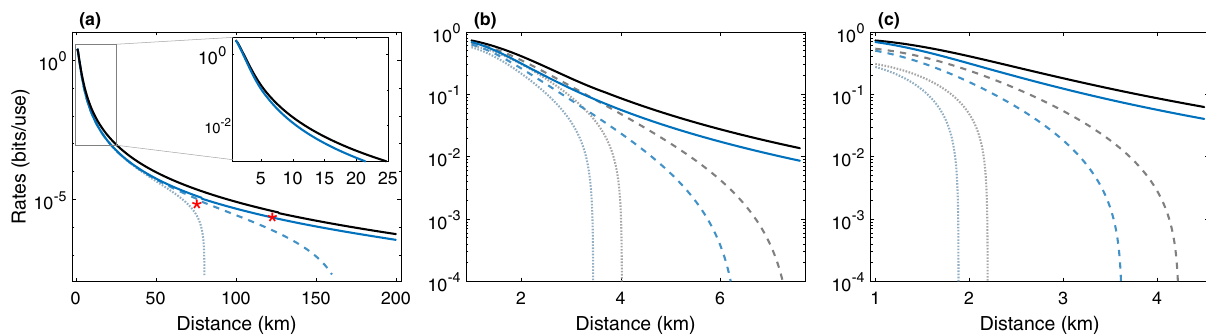
Fig. 3 Free-space optical quantum communications in a moderate-to-strong turbulent space. We indicate night- and day-time conditions by black and blue curves, respectively. In a , we plot the ultimate pure-loss bound of Eq. (20) with an ideal receiver, η eff = 1 and (cid:2) n ex ¼ 0, at night-time (solid black curves) and day-time (solid blue curve). The dashed (dotted) curves are thermal upper (achievable lower) bounds for an ideal receiver with η eff = 1 and (cid:2) n ex ¼ 0 [cf. Eqs. (21) and (22)]. The red star indicates the distance z i (connecting plots from different equations and therefore presenting small discontinuities). Here, the following set of parameters are considered: λ = 800 nm, α 0 ( λ ) = 5 × 10 − 6 m − 1 , w 0 = a R = 5 cm, Ω fov = 10 − 10 sr, Δ t = 10 ns, Δ λ = 0.1 pm, h 0 = 30 m, so that C 2 n ¼ 1 : 28 ð 2 : 06 Þ ´ 10 (cid:3) 14 m (cid:3) 2 = 3 for night (day). Also, we have thermal noise (cid:2) n B ¼ 4 : 75 ´ 10 (cid:3) 12 ð ´ 10 (cid:3) 7 Þ photons per mode at night (day). In b and c , we assume a lossy and noisy receiver with η eff = 0.5 and, respectively, (cid:2) n ex ¼ 0 : 01 and (cid:2) n ex ¼ 0 : 05. As in panel ( a ), we compare the pure-loss rates (solid) with the thermal-noise bounds (dashed) and the achievable lower bounds red star, which is different for night and day operation (the right